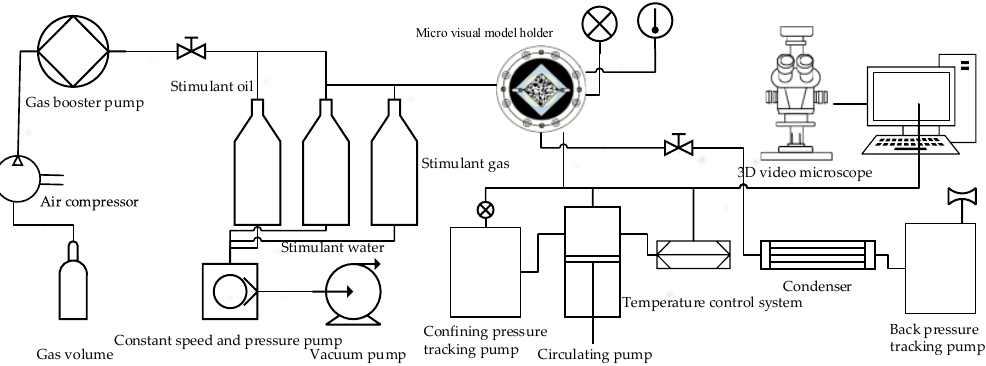
150 ◦ C, and the pressure could reach 70 MPa. 150°C, and the pressure could reach 70 MPa.